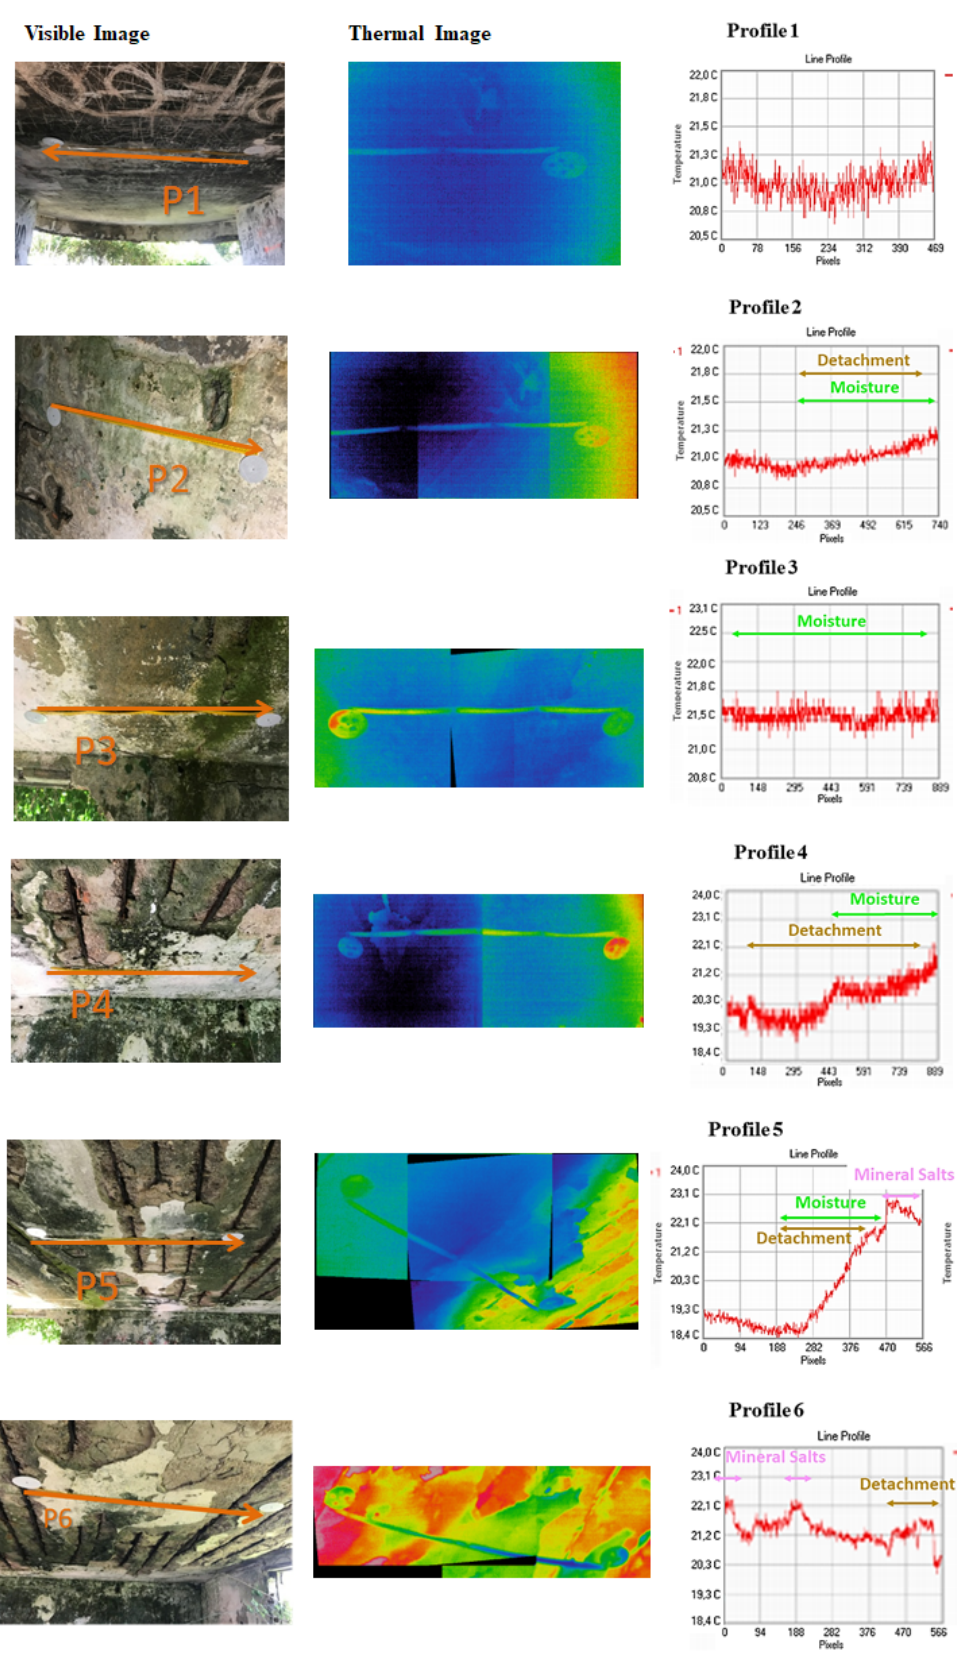
Figure 11. Temperature evolution for each profile line with the corresponding visible and thermographic images for context information.